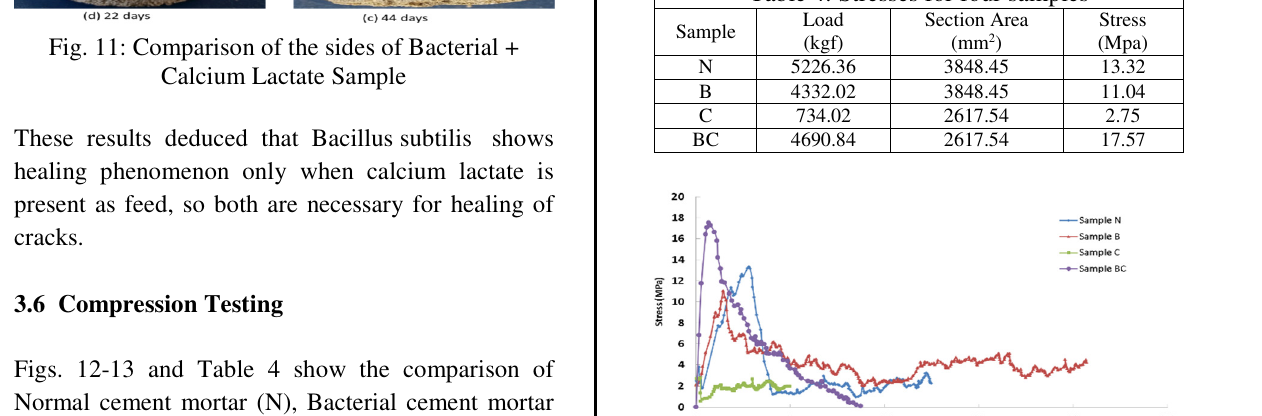
Table 4: Stresses for four